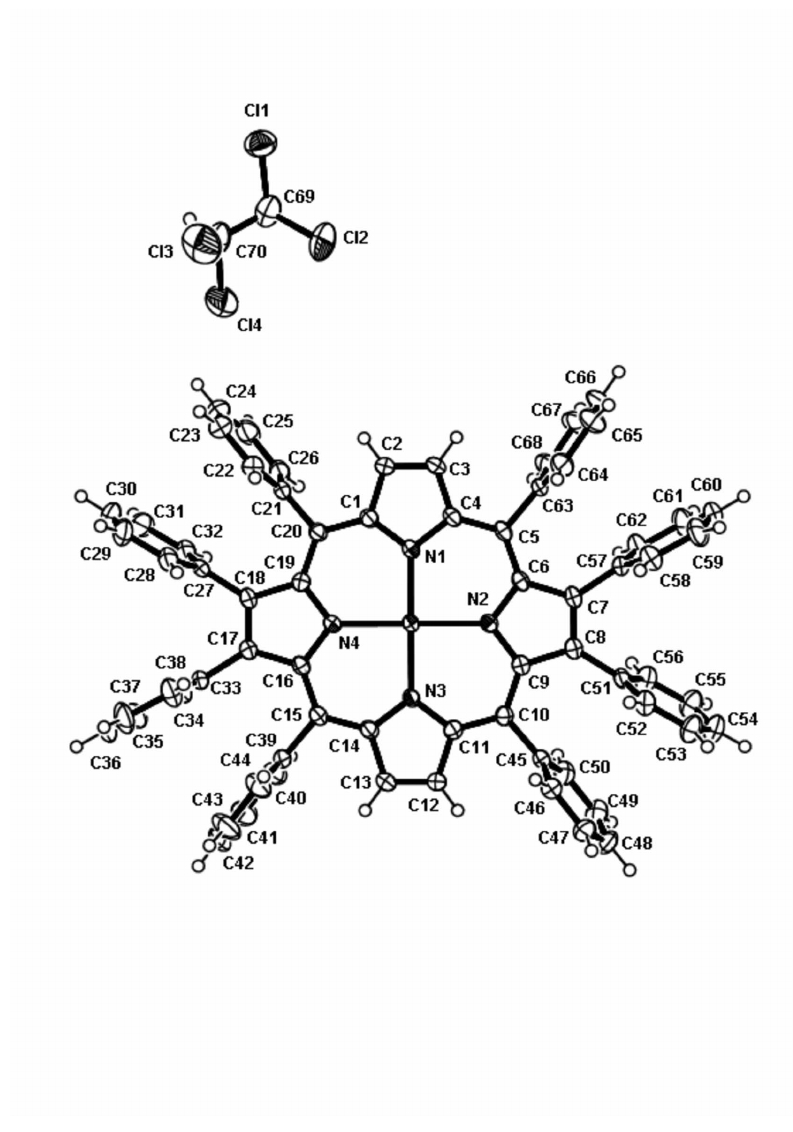
Figure 1 ORTEP plot of the molecular structure of CuTPP(Ph)